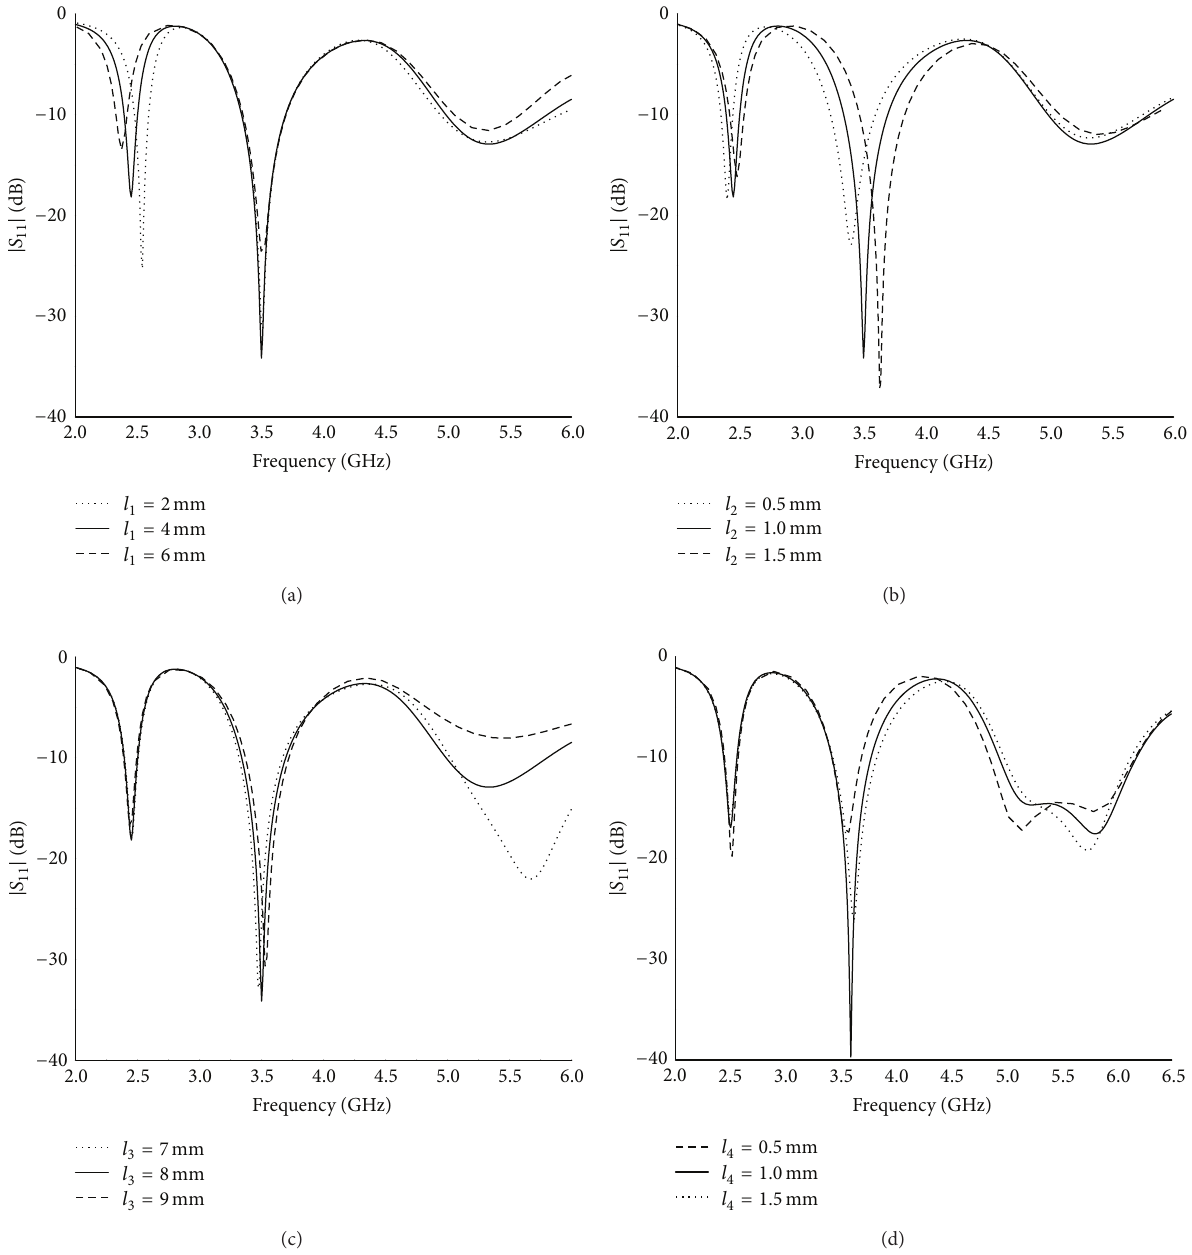
Figure 6: Simulated reflection coefficients of the triband antenna with varied(a) 𝑙 1 , (b) 𝑙 2 , (c) 𝑙 3 , and (d) 𝑙 4